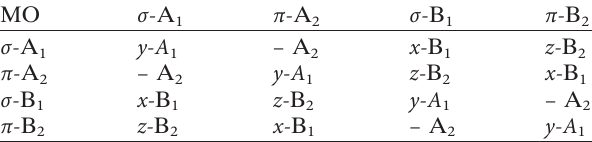
Table 2: Quantum transitions allowed by the symmetry group C with absorption or emission of